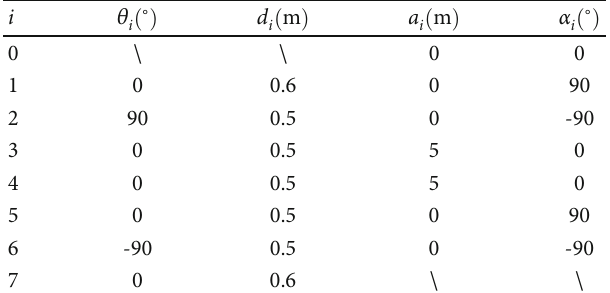
Figure 6: The kinematic model of the 7-DOF space manipulator. Table 6: Initial DH parameters of the 7-DOF space manipulator.